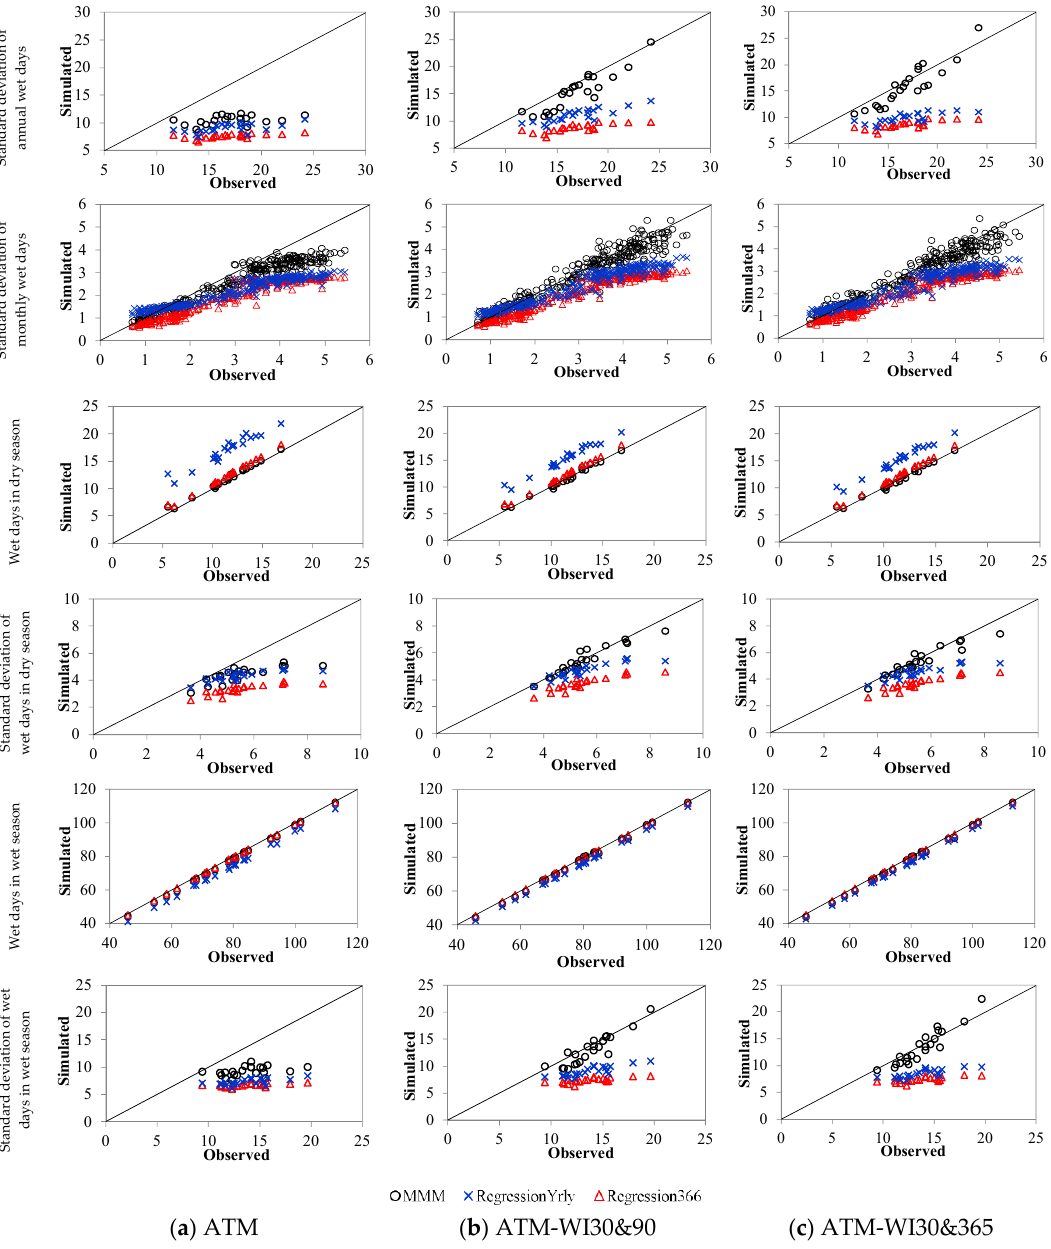
Figure 4. Multisite model results simulated by all downscaling techniques for calibration: ( a ) using ATM as predictors; ( b ) using ATM-WI30&90 as predictors; and ( c ) using ATM-WI30&365 as predictors. Each dot on the plot represents a station. Black hollow circles are for MMM, blue crosses are for RegressionYrly and red triangles are for Regression366 models.